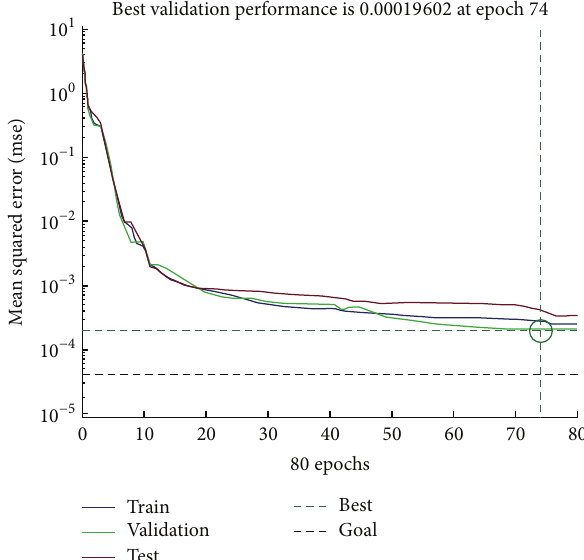
Figure 6: Convergence of adaptive dynamical NN for 80 epochs for the pickling process.